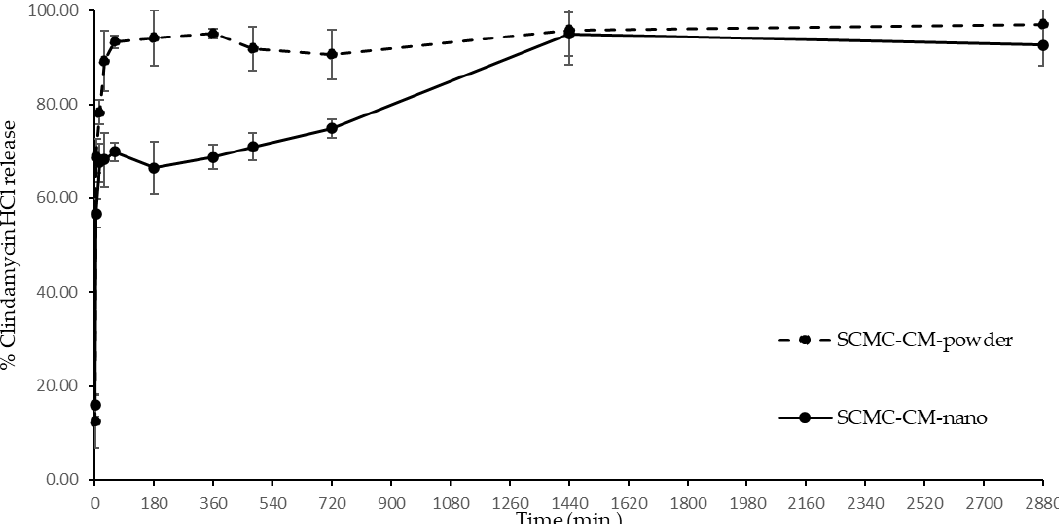
Figure 7. The release profile of clindamycin HCl power (SCMC-CM-powder) and clindamycin HCl in CMCS-Ca 2+ nanoparticles (SCMC-CM-nano) from SCMC